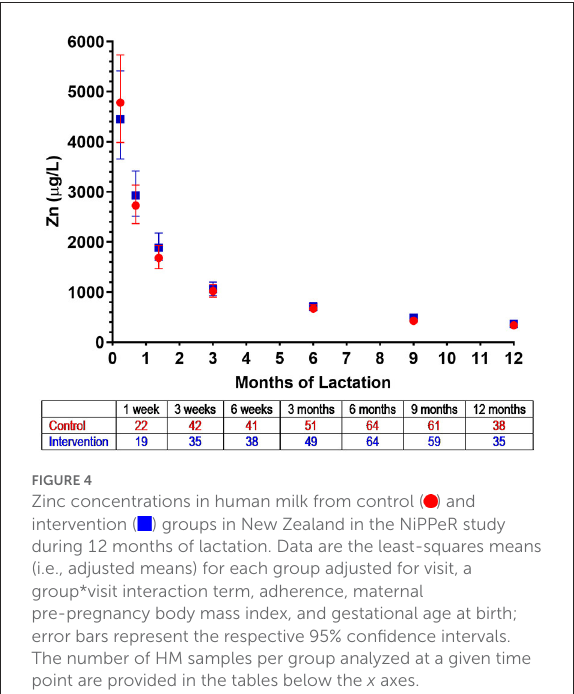
FIGURE4 Zinc concentrations in human milk from control ( ) and intervention ( ) groups in New Zealand in the NiPPeR study during 12 months of lactation. Data are the least-squares means (i.e., adjusted means) for each group adjusted for visit, a group*visit interaction term, adherence, maternal pre-pregnancy body mass index, and gestational age at birth; error bars represent the respective 95% confidence intervals. The number of HM samples per group analyzed at a given time point are provided in the tables below the x